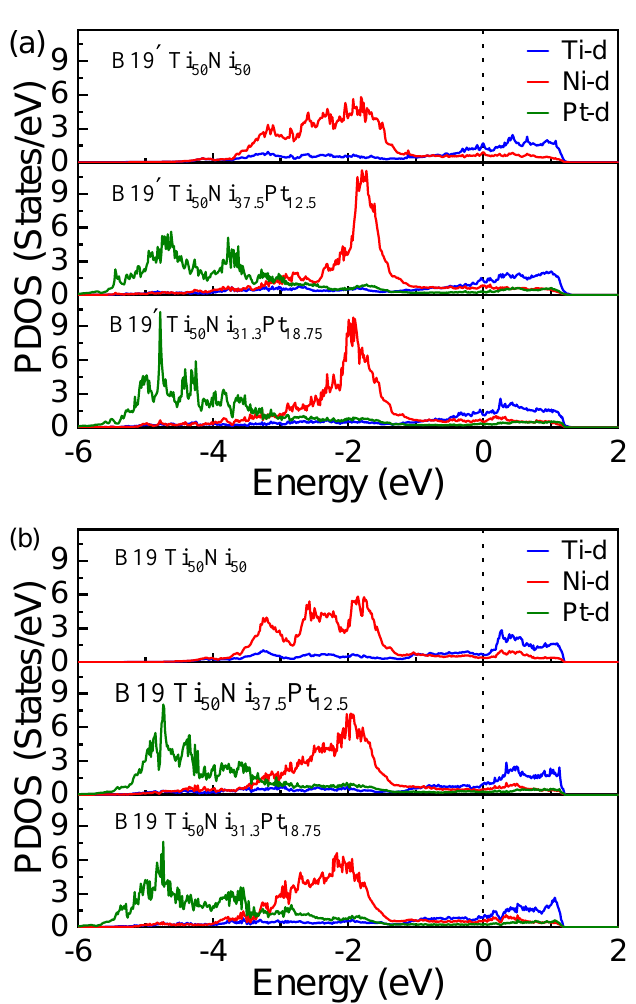
Figure 5. Partial density of states (PDOSs) of martensite ( a ) B19 (cid:48) and ( b ) B19 phase of Ti 50 Ni 50 − x Pt x ( x = 0, 12.5, 18.75) alloys for the Ti, Ni, and Pt site. The vertical line denotes the Fermi level, which is located at 0